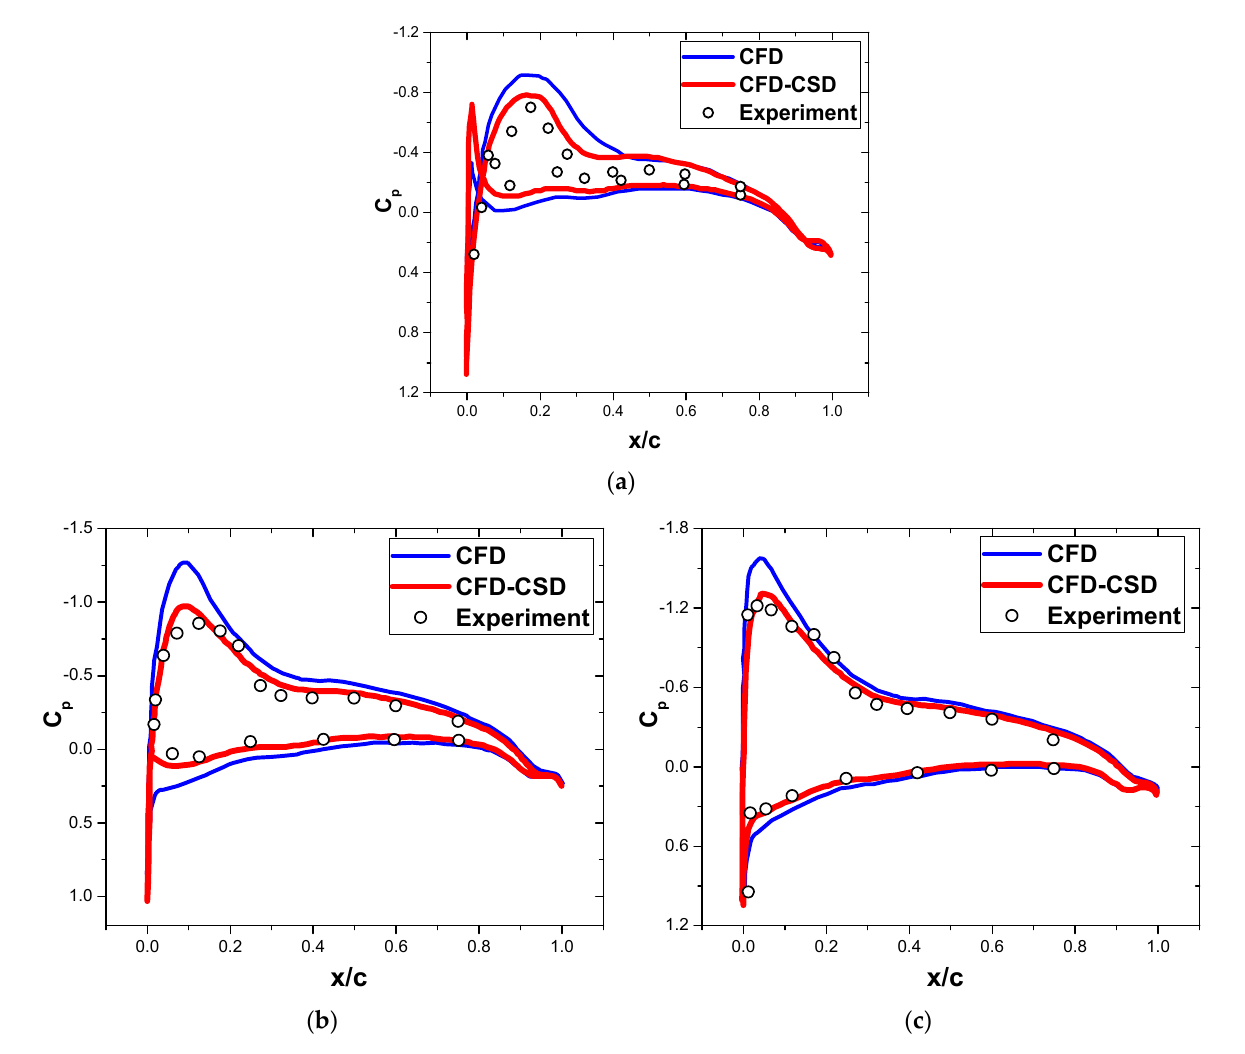
Figure 10. Pressure coefficient of the 7A blade with a high advance ratio (r/R = 0.975). ( a ) ψ = 150°. ( b ) ψ = 180°. ( c ) ψ = 210°.